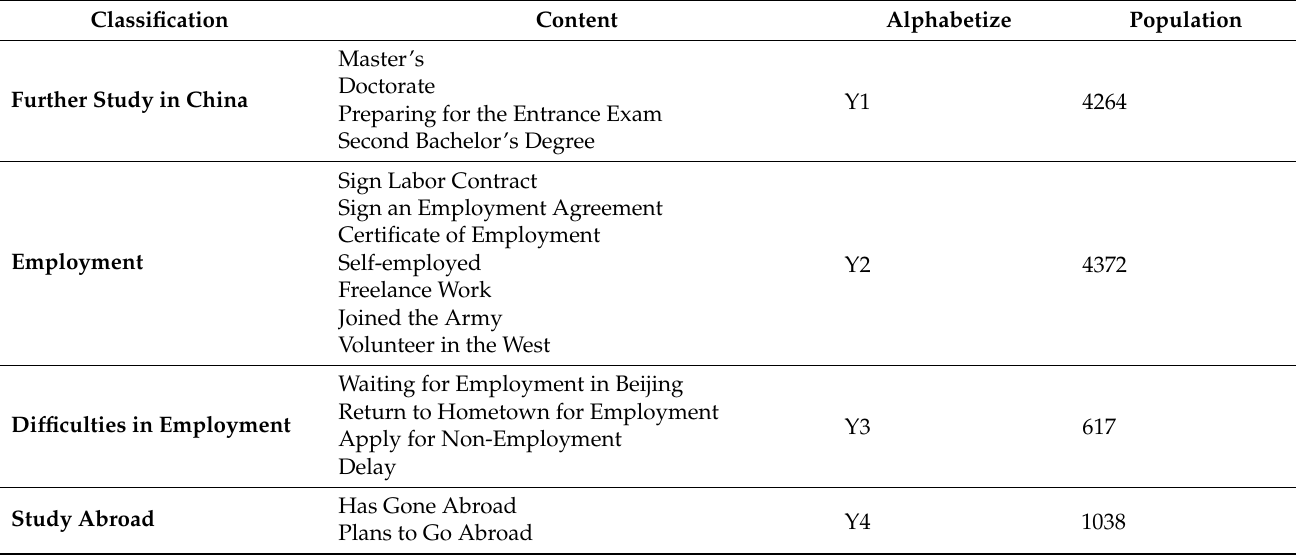
Table 2. Breakdown of students’ graduation